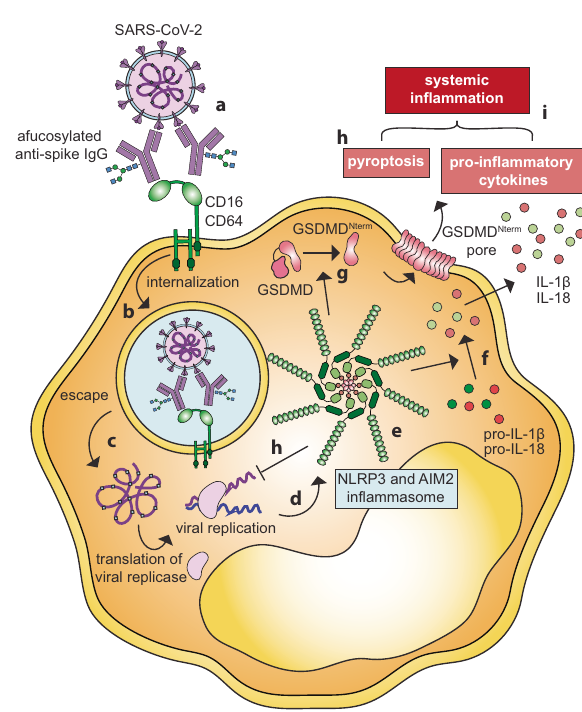
Fig. 1 Antibody-mediated SARS-CoV-2 infection of monocytes via Fc γ Rs. a Immune complexes composed of afucosylated anti-SARS- CoV-2 IgG and virus infect monocytes via Fc γ RIIIa and Fc γ RI, which initiates b phagocytosis. c SARS-CoV-2 escapes degradation via the phagolysosome and initiates replication in the cytoplasm. d Replication of SARS-CoV-2 activates NLRP3 and AIM2 leading to the formation of e the NLRP3 and AIM2 in fl ammasome complex. f In fl ammasome activation induces cleavage of pro-IL-1 β and pro-IL- 18 resulting in the release of pro-in fl ammatory cytokines IL-1 β and IL-18. g Gasdermin D (GSDMD) is cleaved and inserted into the membrane instigating pyroptosis. h In fl ammasome activation and pyroptotic cell death halt SARS-CoV-2 replication. i Secretion of IL-1 β and IL-18 and pyroptosis contribute to systematic in fl ammation, associated with severe COVID-19. GSDMD amino-terminal cell death domain (GSDMD Nterm